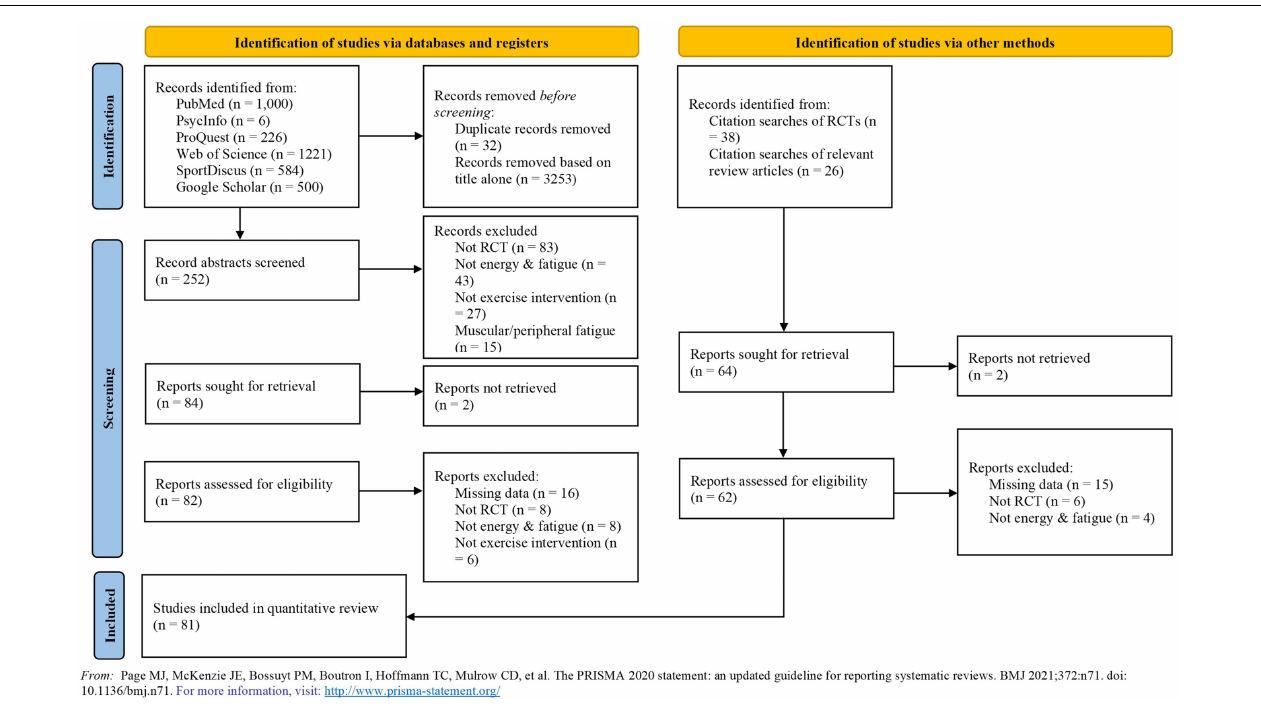
FIGURE 1 | PRISMA flow diagram. Detailed flow of studies examined from the initial search to the final